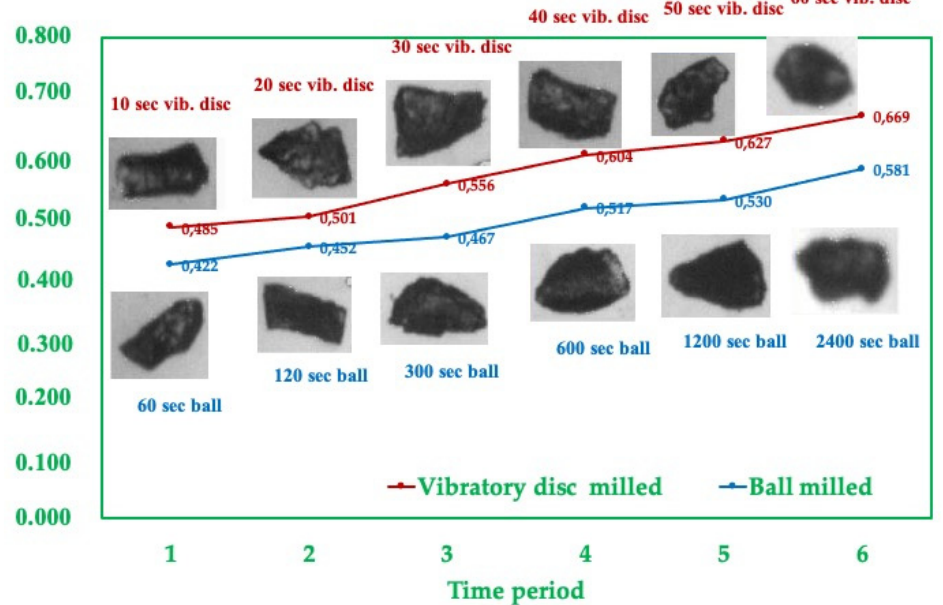
Figure 33. Changing particle shape depends on grinding time by using different mills [593].